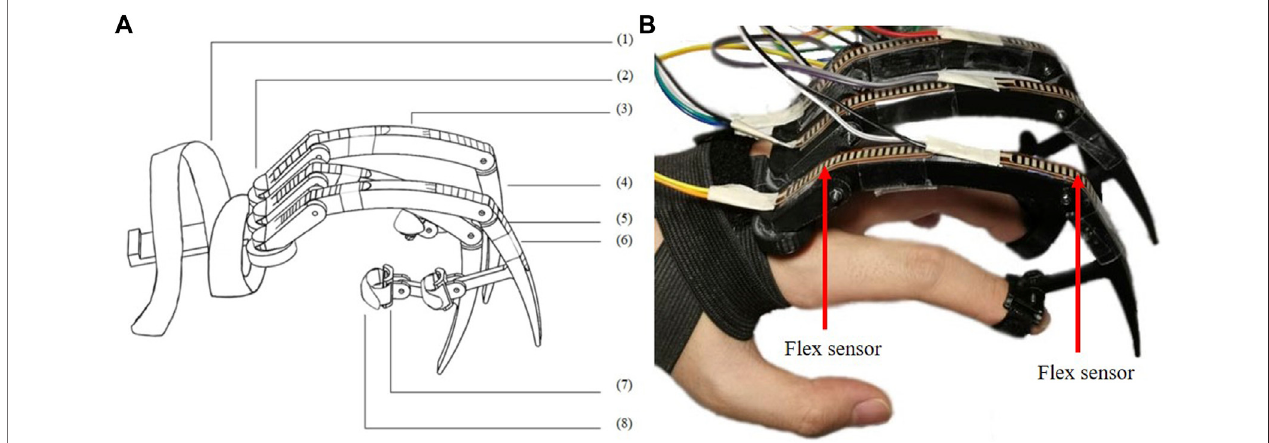
FIGURE 5 | Glove 2 is designed for Tip Position Mapping (TPM) (A) The design consists of (1) Elastic knit band with Velcro (2) 3D printed base. (3) 3D printed dactylus 1. (4) 3D printed dactylus 2. (5) Flex sensors (Adafruit Short Flex Sensors 25k Ω - 100 k Ω ) (6) Slides (7) 3D printed ring (8) Finger strap (B) The user is shown wearing the device such that tip motion is a result of MCP, PIP and DIP fl